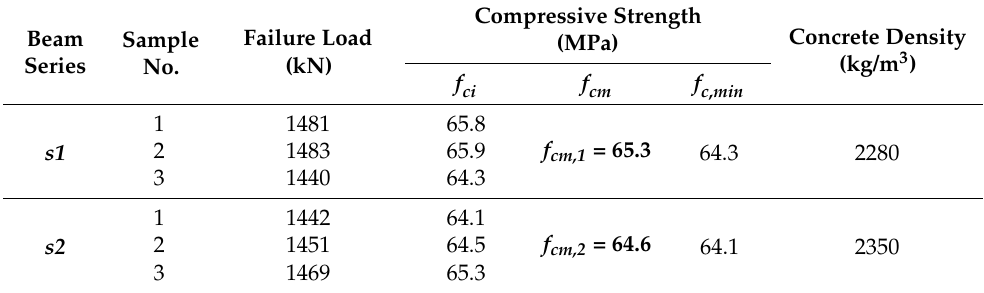
Table 1. Compressive strength of concrete.